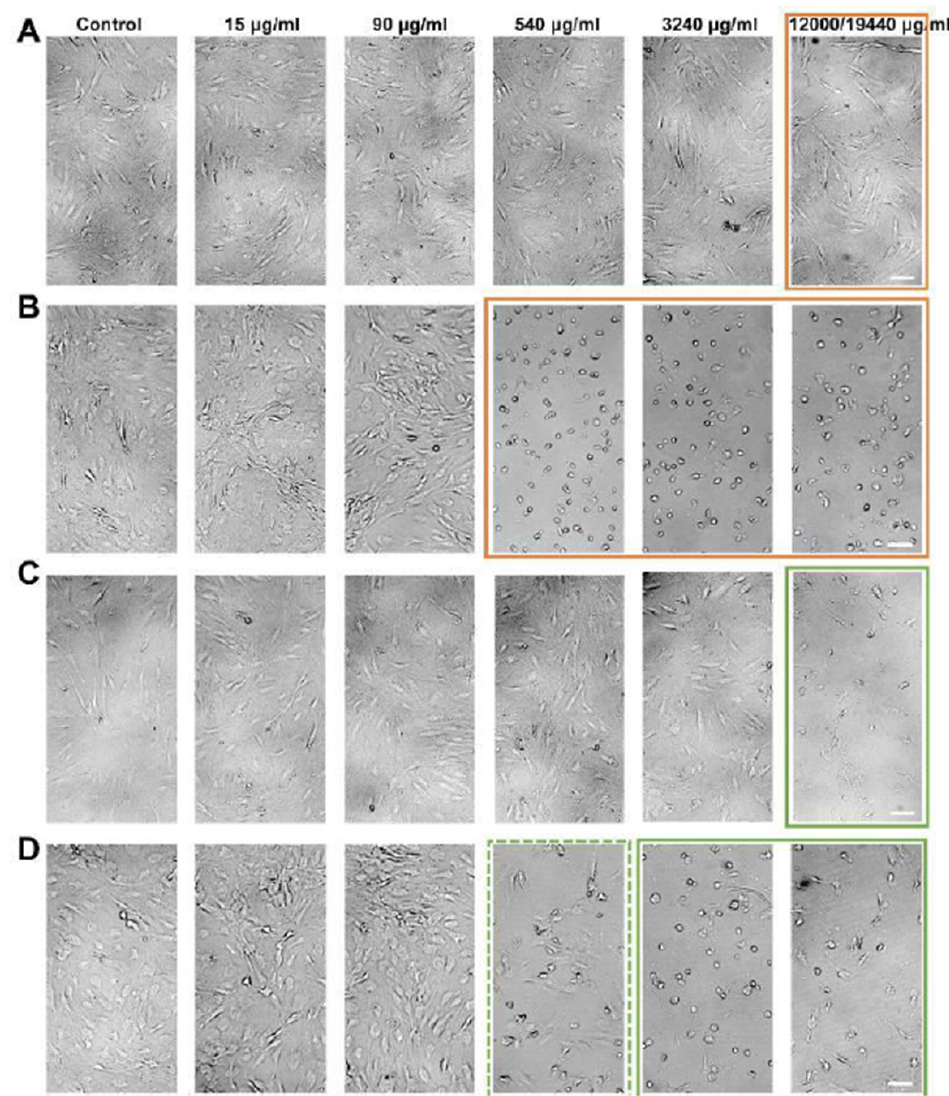
Figure 6. Example pictures of morphological changes in ADSC at 5 × magnification. ( A , B ) ADSCs treated with clindamycin for 24 h or 9 days, respectively. The orange frame marks the reduced cell density ( A ) or the loss of fibroblast-like morphology ( B ). ( C , D ) ADSCs treated with cefazolin for 24 h or 9 days, respectively. The green frame marks reduced cell density and loss of fibroblast-like morphology.